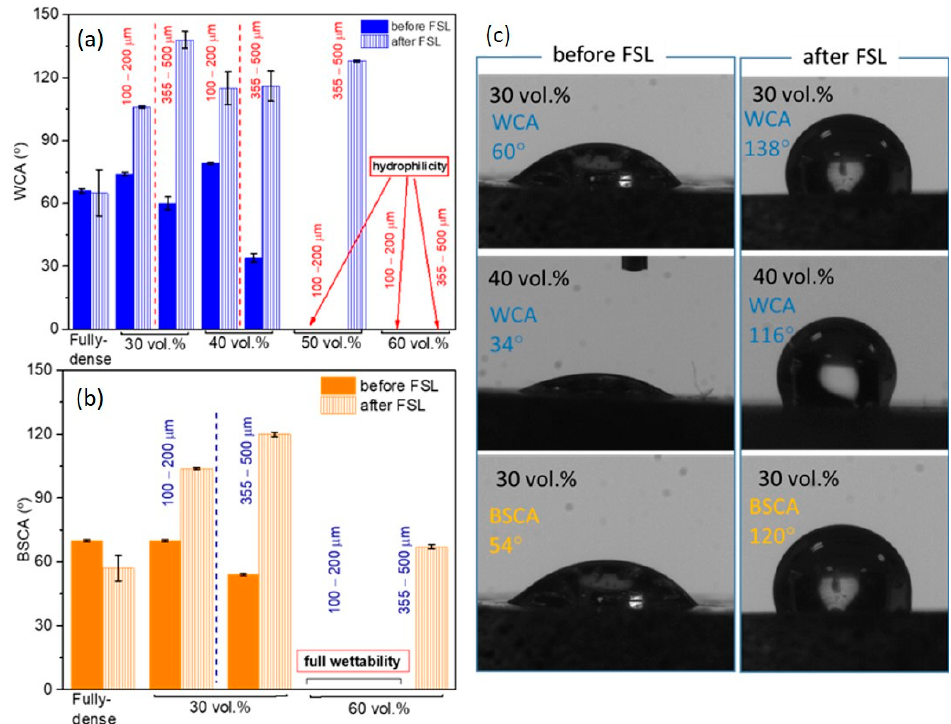
Figure 6. Wetting analysis of the porous c.p. Ti substrates: ( a ) Water Contact Angle (WCA) values of surfaces with different porosity percentages and pores range size before and after the FSL (Femto Second Laser) treatment; ( b ) bovine serum contact angle (BSCA) values of porous surfaces before and after the FSL treatment; ( c ) images representing the wetting of water and bovine serum droplets deposited on c.p. Ti porous surfaces (355–500 μ m pores range size) before and after FSL treatment.